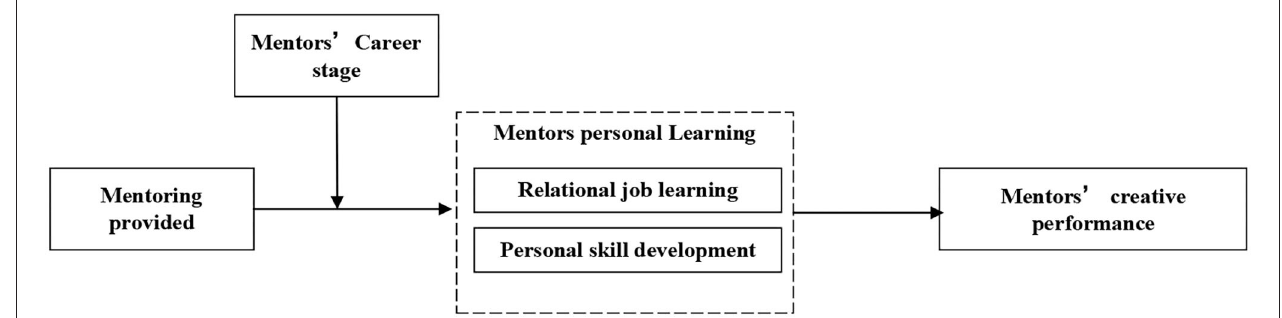
FIGURE 1 | A conceptual